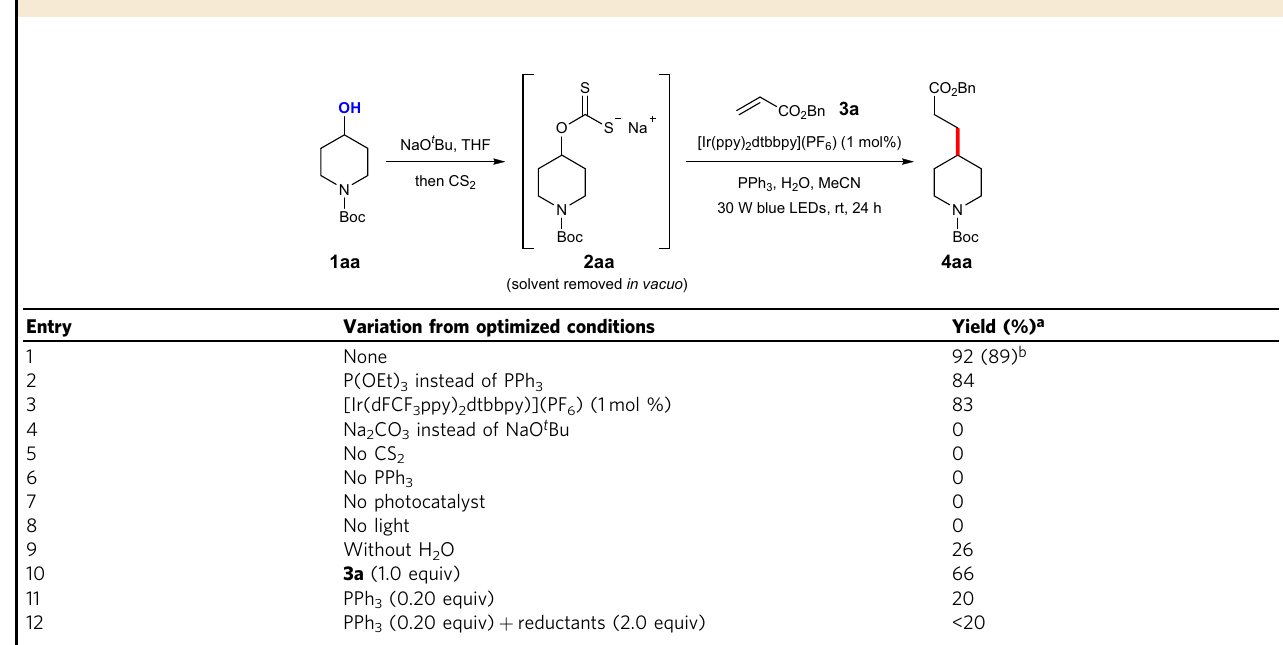
Table 1 Optimization and control